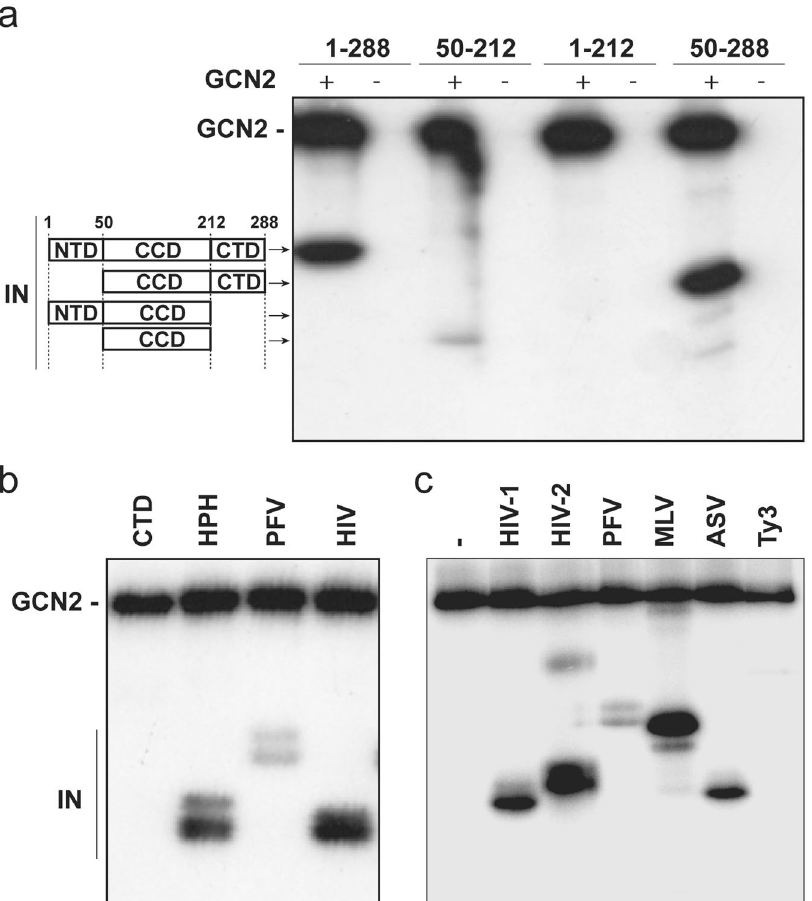
Figure 4. Determination of the IN domains targeted by GCN2. ( a ) Phosphorylation by GCN2 of the full-length HIV-1 IN (1–288), the CCD (50–212) or the two-domain fragments NTD + CCD (1–212) and CCD + CTD (50–288). ( b ) Phosphorylation by GCN2 of the isolated HIV-1 CTD (212–288), the HPH chimeric protein and the IN from PFV and HIV-1. ( c ) Phosphorylation by GCN2 of full-length